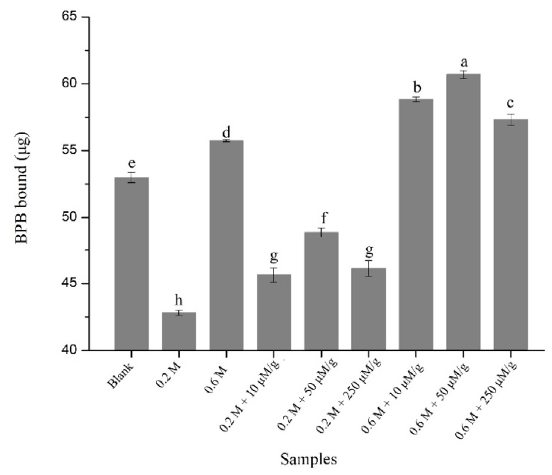
Figure 1. Surface hydrophobicity of the non-oxidized MPs (blank) and oxidized MPs prepared with HYP (10, 50, and 250 µ M/g) at different NaCl concentrations (0.2 and 0.6 M). Values are means ± SD. Di ff erent le tt ers indicate signi fi cant di ff erences ( p < 0.05) ( n = 3).